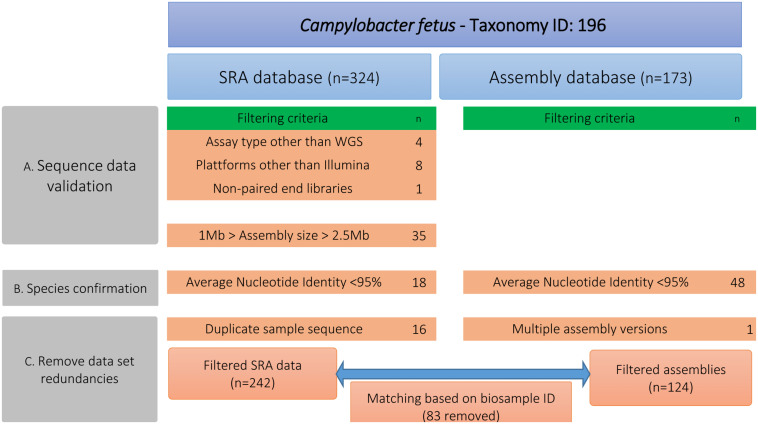
Different steps for filtering the publicly available genomic data of Campylobacter fetus including number of filtered data sets. Step A performed quality assurance via removing genomes that deviated from the average C. fetus genome size (∼1.8 Mbp ± 25%). Step B measured pairwise ANI and excluded genomes with <95% accordance. Step C removed data redundancies by matching raw sequence data and genome assemblies based on the BioSample-ID.